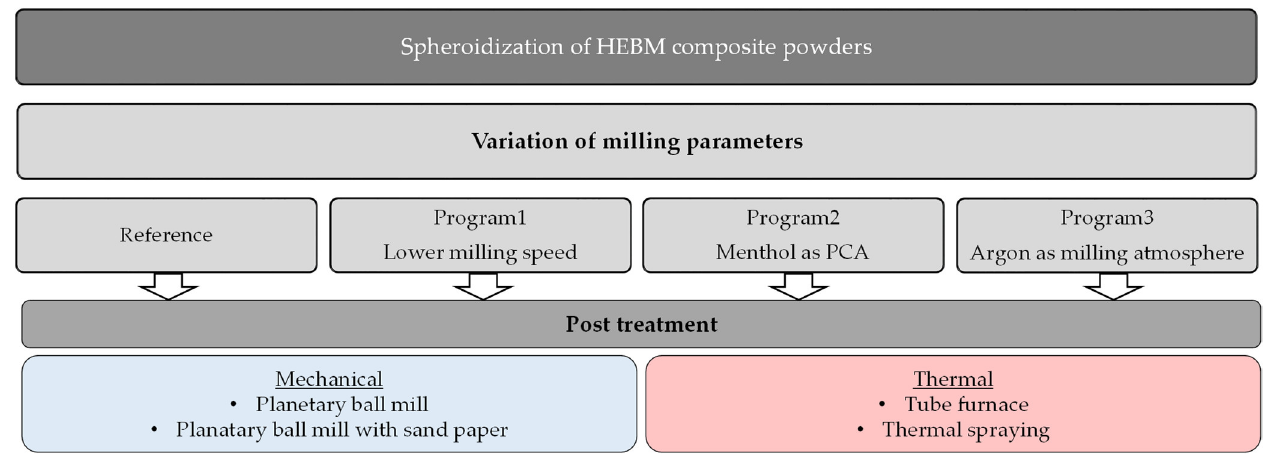
Figure 2. Overview of the different approaches used to influence the morphology of the composite